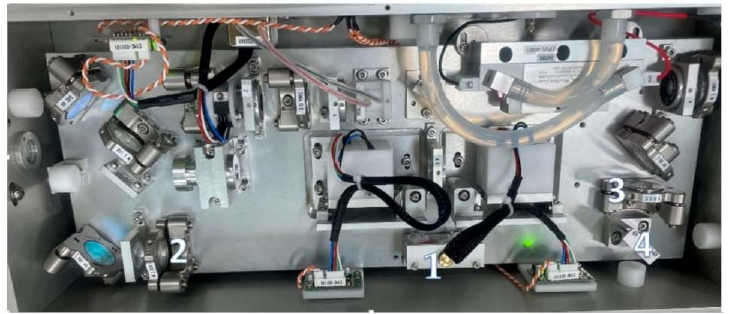
Figure 3. PALLAS laser head: 1 is Ti:Sapphire crystal (in the holder); 2 and 3 are total and output mirrors, respectively; 4 is